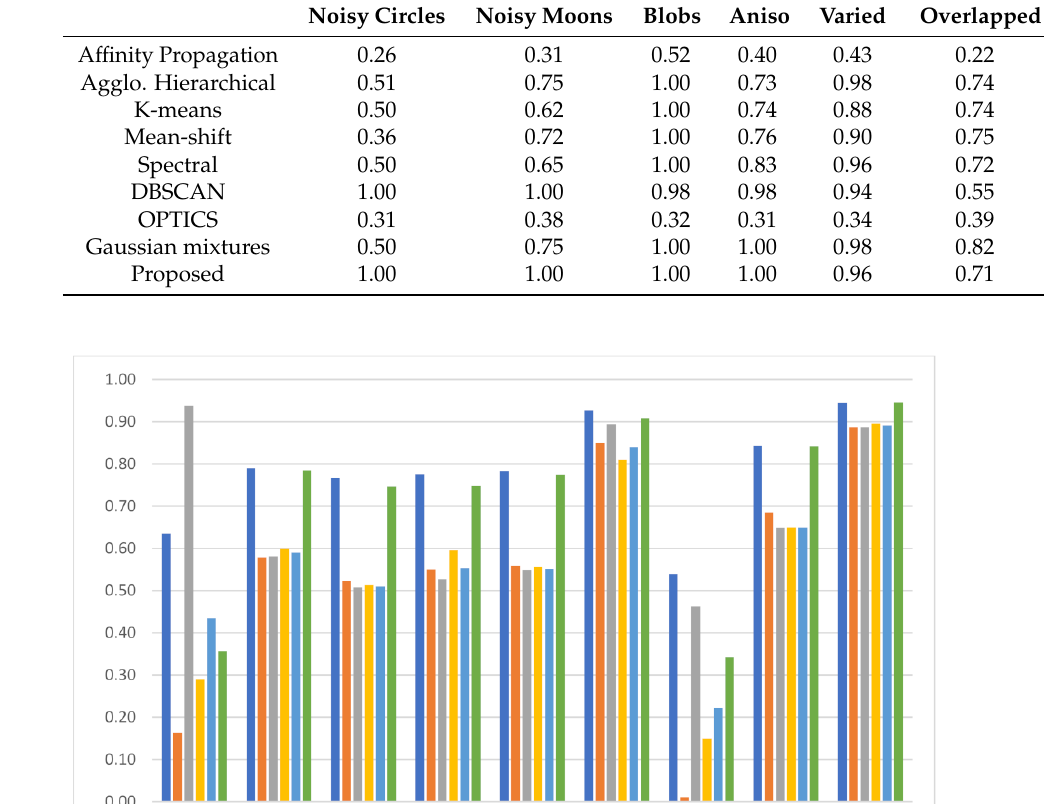
Table 7. The Fowlkes–Mallows of affinity propagation, agglomerative hierarchical, k-means, mean- shift, spectral, DBSCAN, OPTICS, Gaussian mixtures, and the proposed clustering methods on noisy circles, noisy moons, blobs, anisotropic, varying variance, and overlapping datasets.